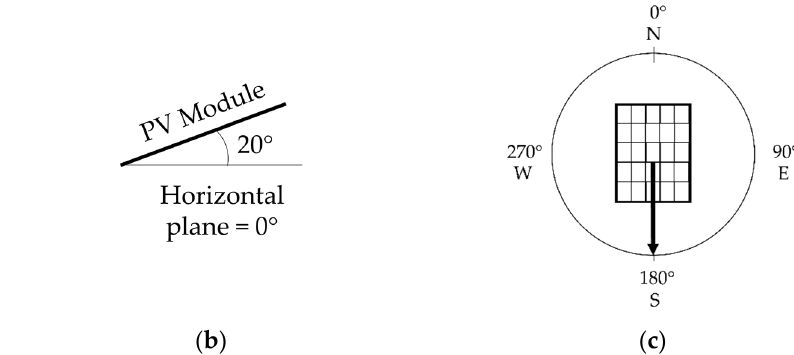
Figure 2. ( a ) Module’s dimensions; ( b ) module seen from the east and its tilt in relation to the horizontal plane; ( c ) module seen from above and its orientation.